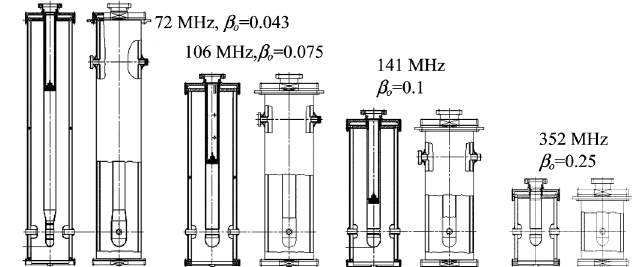
FIG. 1. Left: Typical shape of the field distributions along the beam axis in QWRs. Blue: E ð z Þ . Right: Sketch of the beam port section of a QWR, cB x with the reference frame used in this paper. L is the cavity active length; g and d are the physical gap length and gap-to-gap distance.